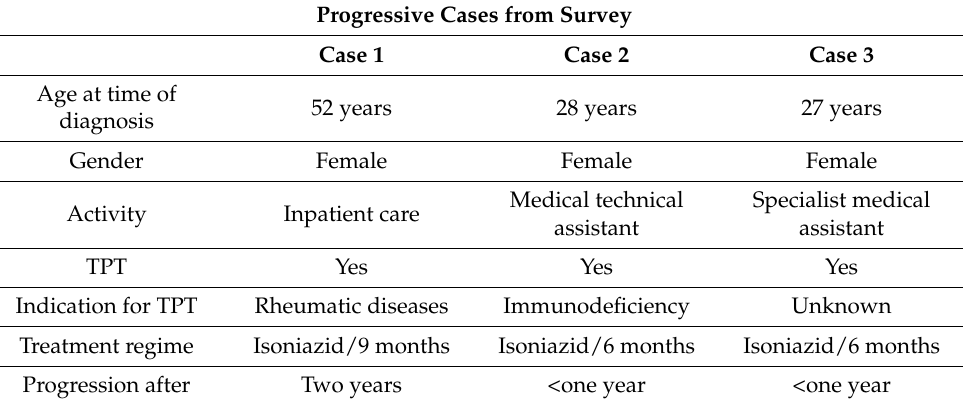
Table 6. Case summary of progressive cases based on survey.